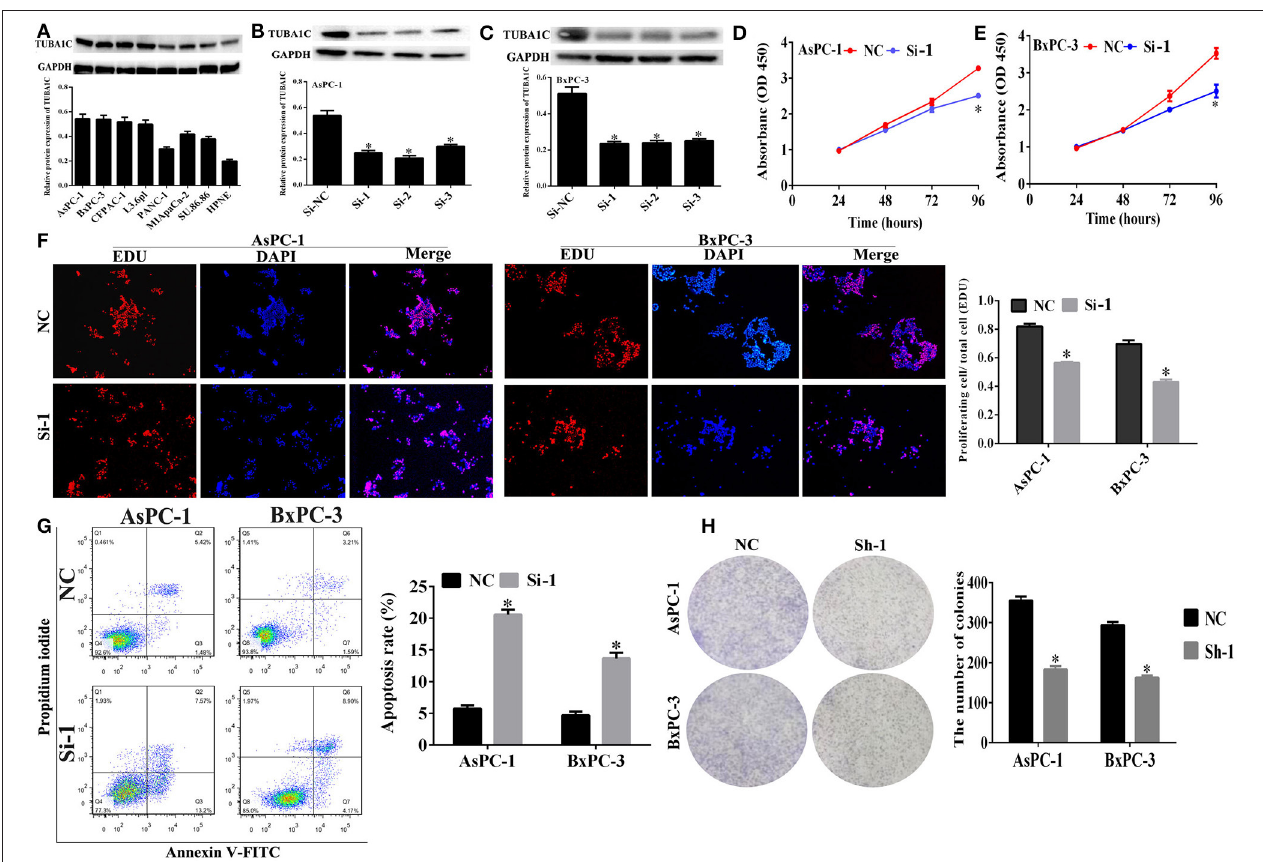
FIGURE 3 | The effect of TUBA1C knockdown on cell viability and apoptosis in pancreatic ductal adenocarcinoma (PDAC) cells in vitro . (A) TUBA1C protein expression levels in normal pancreatic cell line (HPNE) and seven PDAC cell lines. (B,C) Evaluation of TUBA1C expression in AsPC-1 and BxPC-1 cells after siRNA transfection. (D,E) The effect of TUBA1C knockdown on proliferation ability of AsPC-1 and BxPC-3 cell lines detected by Cell Counting Kit-8 (CCK-8) assay and (F) EdU assay. (G) The effect of TUBA1C knockdown on cell apoptosis in AsPC-1 and BxPC-3 cells determined by flow cytometry. (H) The colony formation assay for evaluation of the proliferation of AsPC-1 and BxPC-3 cells after shRNA transfection. All results are displayed as the mean ± SD ( n = 3; * P < 0.05) compared with the negative control (NC) group.